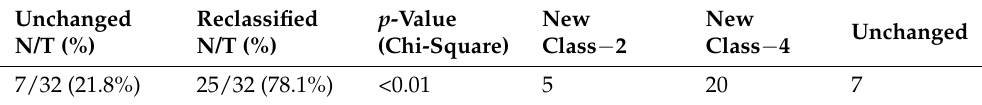
Table 1. Missense VUS reclassification.